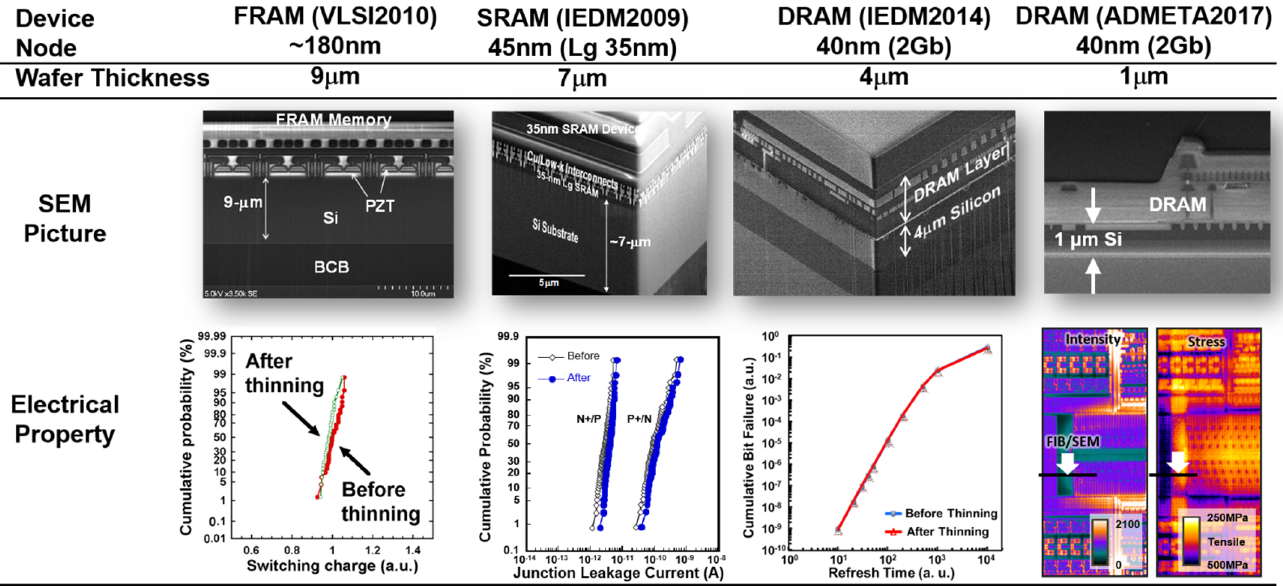
Figure 2. Cross-sectional SEM images and electrical properties after device wafer thinning. Thinning was carried out from 9 to 1 μ m for FRAM, SRAM, and DRAMs, respectively. There was no degradation in the electrical characteristics after thinning, and the circuit area at the critical layer could be observed from the back side of the wafer when the silicon thickness became one micrometer.